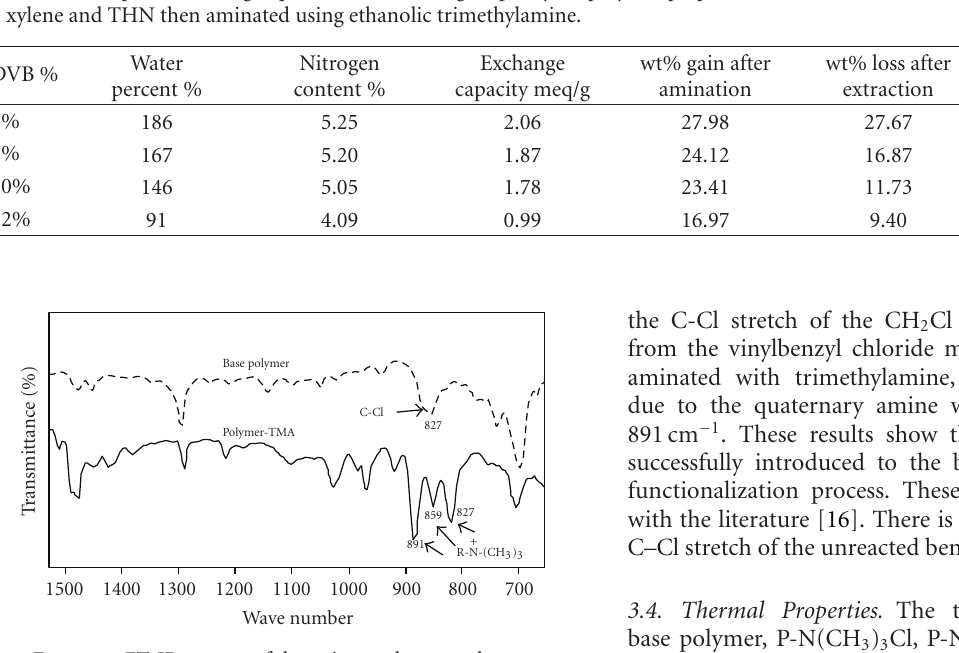
amination degree. Table 2 shows the variation of water content, nitrogen content, and ion exchange capacity as a function of cross-linkage